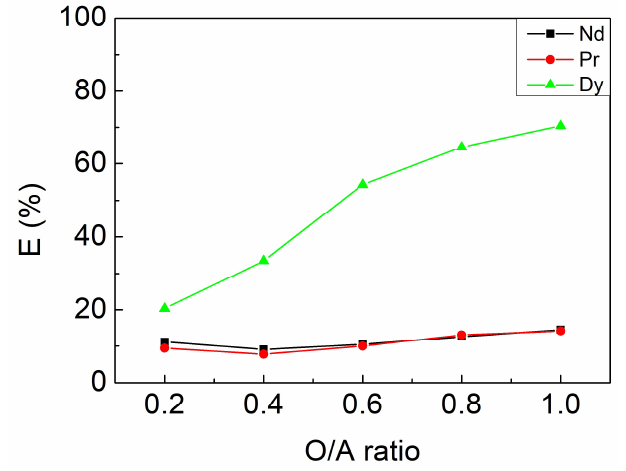
Figure 5. Extraction efficiencies at different O/A ratios. Fixed parameters: contacting time of 10 min, pH 3, 2 mM (Cyphos IL 104).